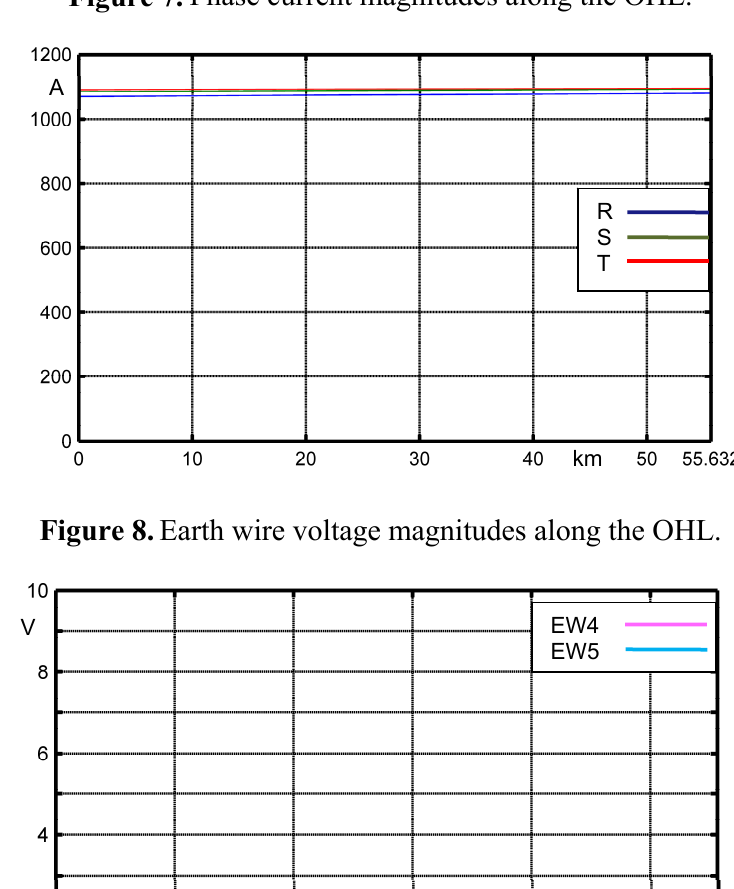
Figure 7. Phase current magnitudes along the OHL.